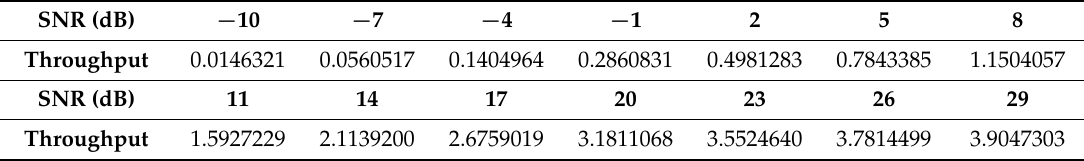
Table 4. System throughput of the 4-bit wideband CQI feedback